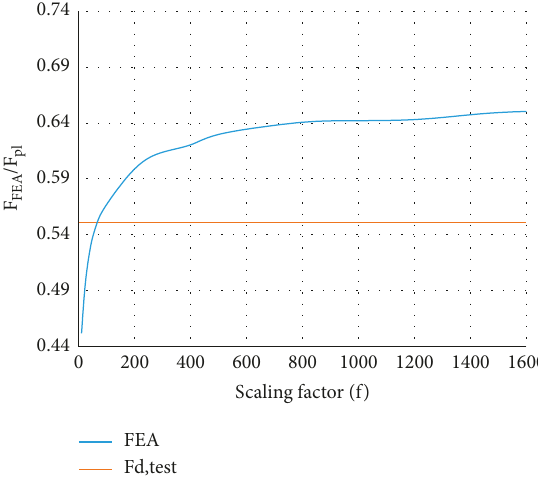
Figure 26: Imperfection sensitivity study. Table 9: Design values for α � a